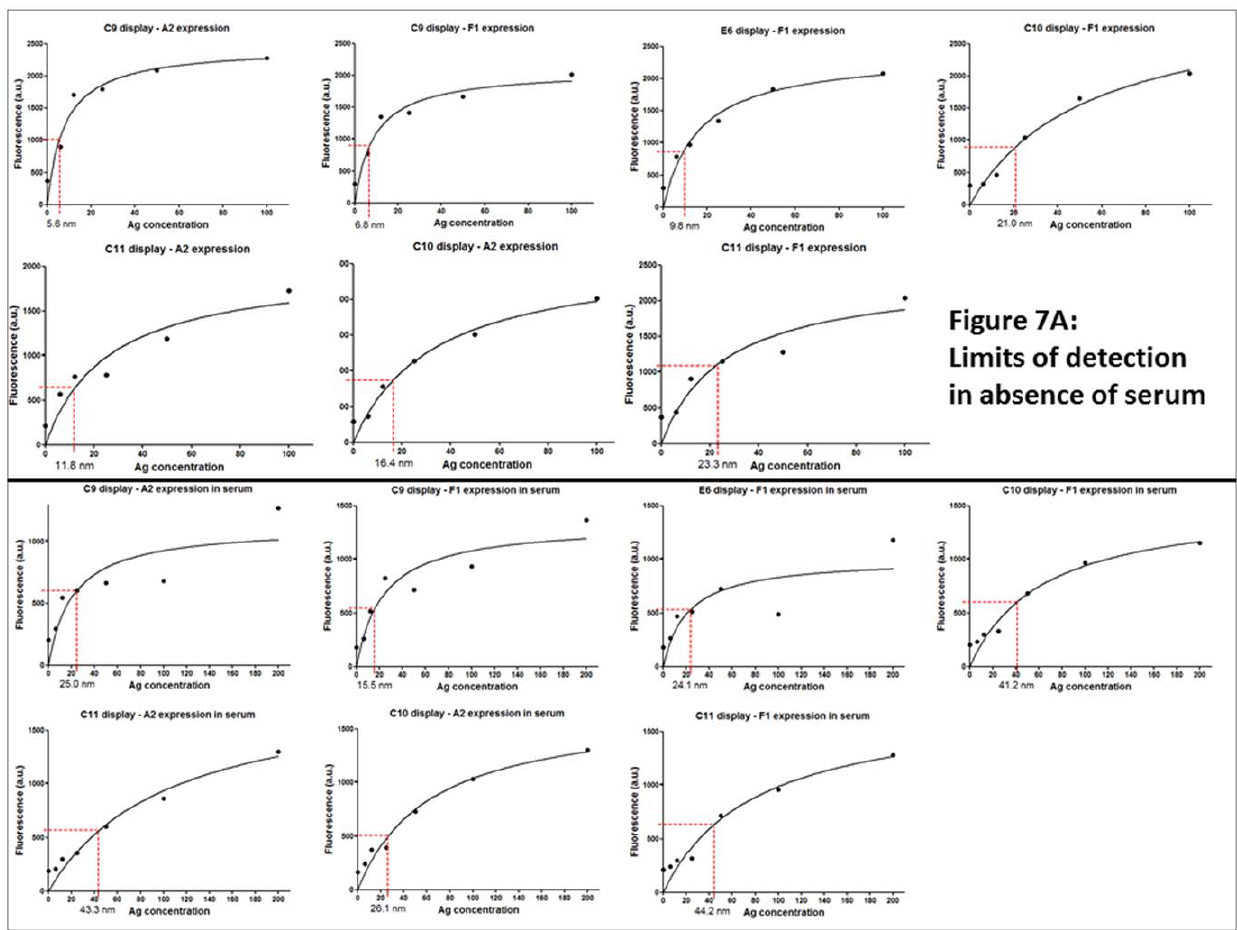
Figure 7. Ag85 detection limits in a sandwich assay. 10 6 yeast displaying the indicated antibodies were induced, washed and resuspended in serial antigen dilutions. Binding was detected by flow cytometry following the addition of the indicated scFv-Fc fusion antibodies as induced culture supernatants, and fluorescent anti-rabbit secondary reagents. The indicated detection limits are defined as the minimal antigen concentration giving a signal three times greater than background. A: Detection in phosphate buffered saline. B: Detection in 1:50 human serum diluted in PBS.